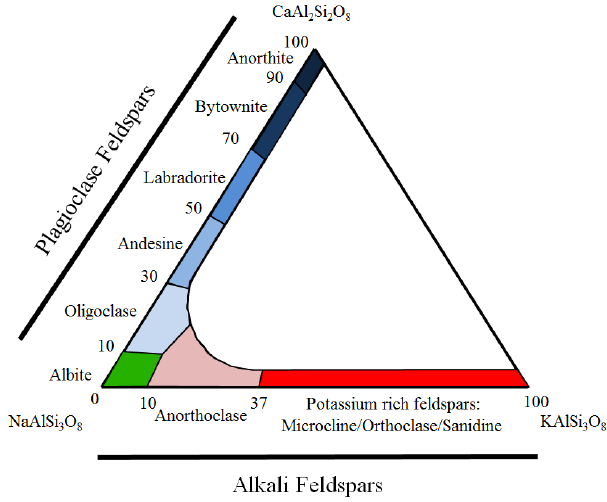
Figure 1. The ternary composition diagram for the feldspars group based on similar figures in the literature (Wittke and Sykes, 1990; Deer et al.,